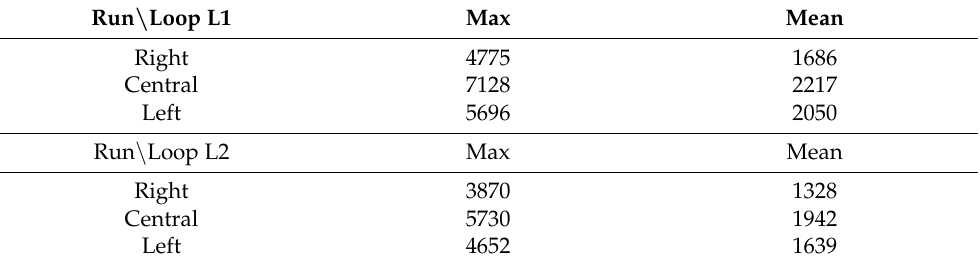
Table 7. Signal characteristics from inductive loops—amplitude and mean signal level